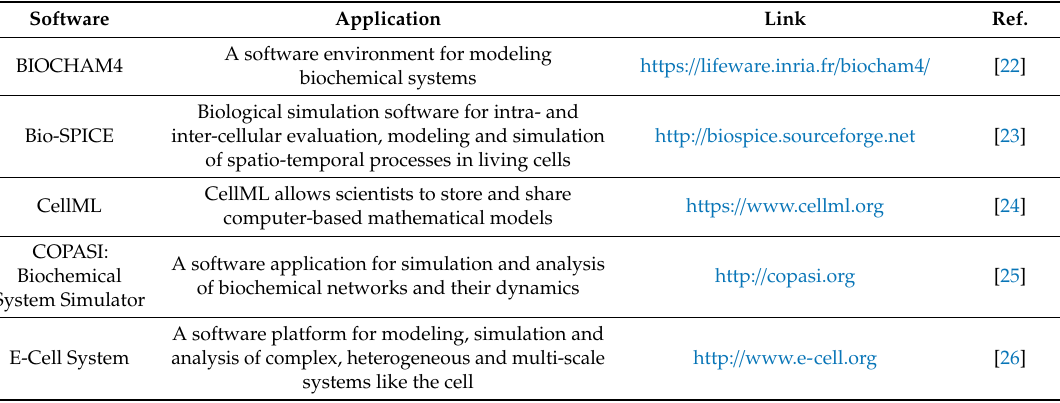
Table 1. List of modeler environments